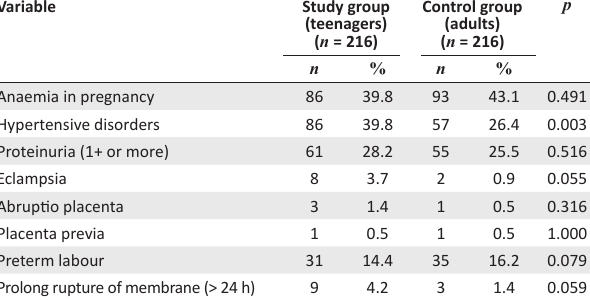
TABLE 2: Pregnancy-related complications.